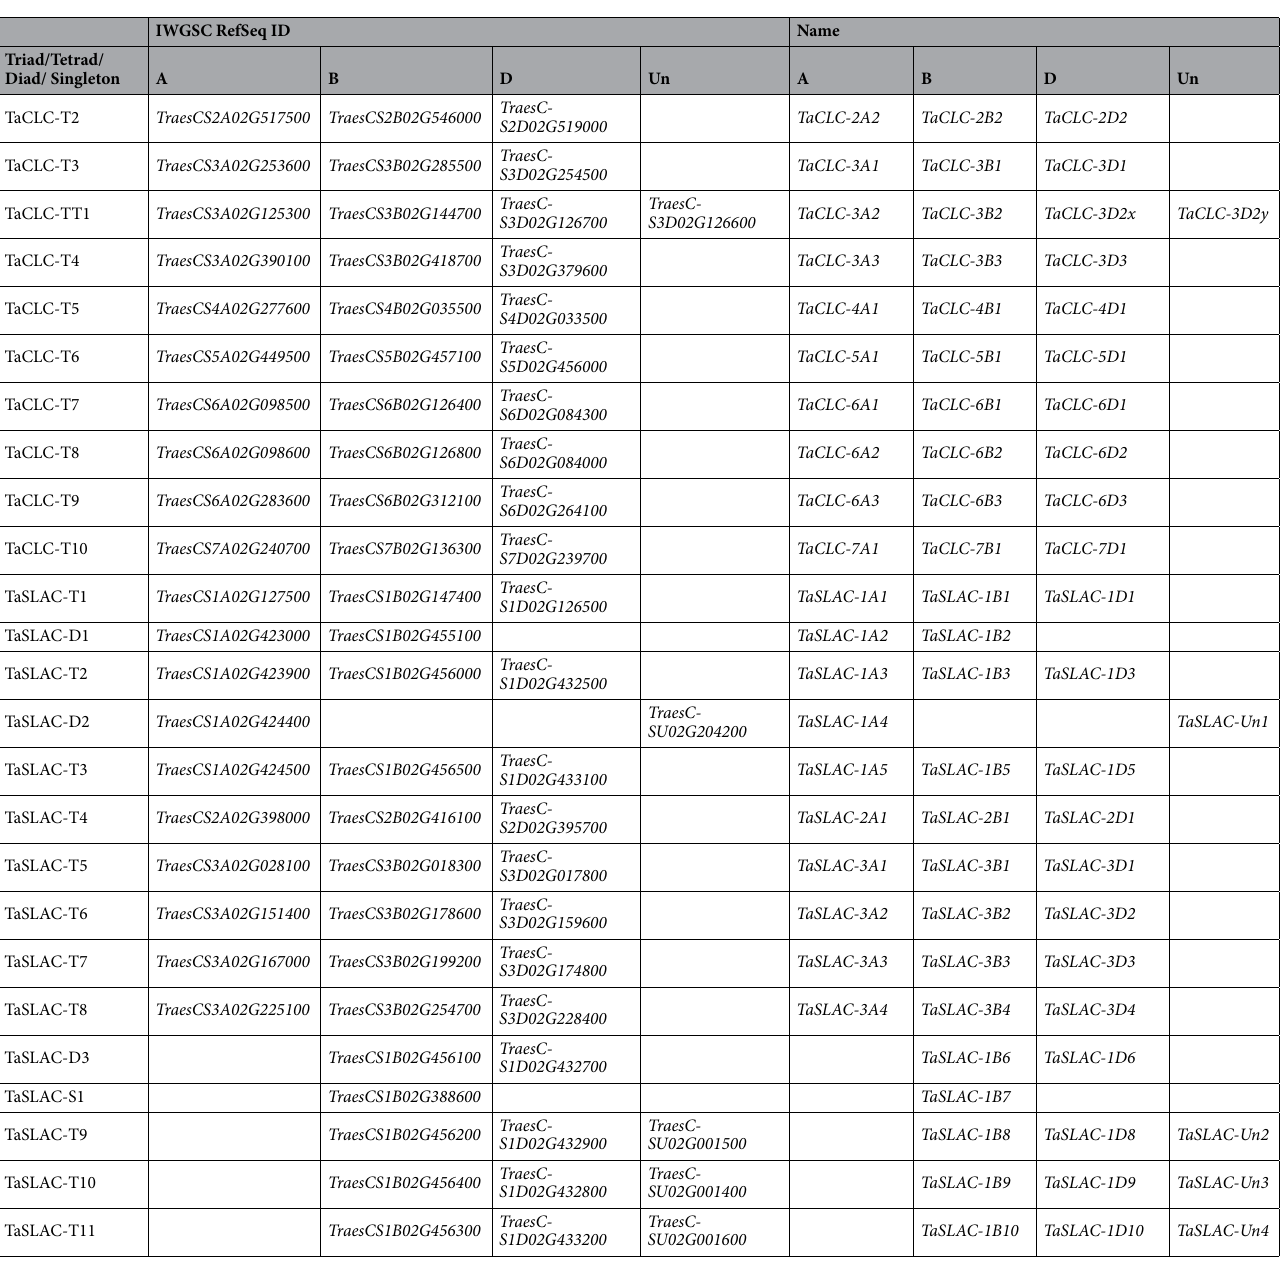
Table 2. Grouping and Naming of nitrate transporter genes identified in wheat genome Refeq